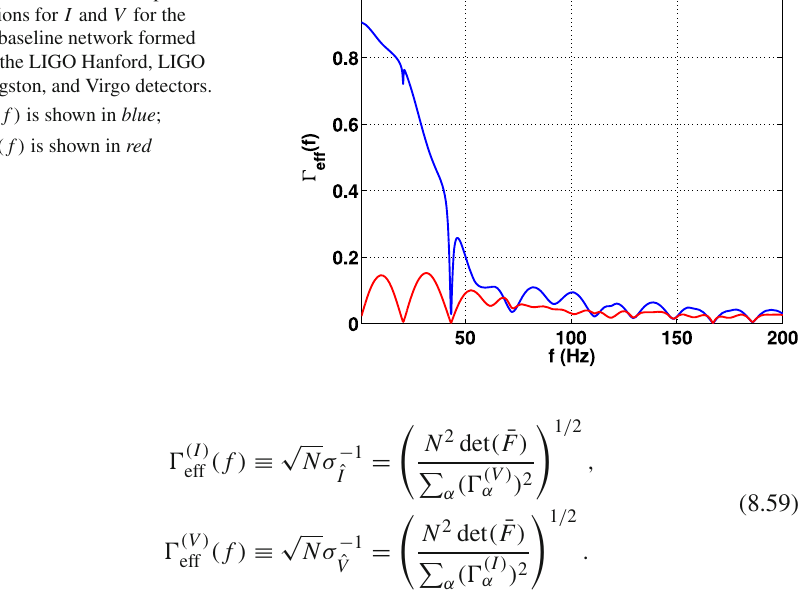
Fig. 62 Effective overlap functions for I and V for the multibaseline network formed from the LIGO Hanford, LIGO Livingston, and Virgo detectors. (cid:13) ( I ) ( f ) is shown in blue eff